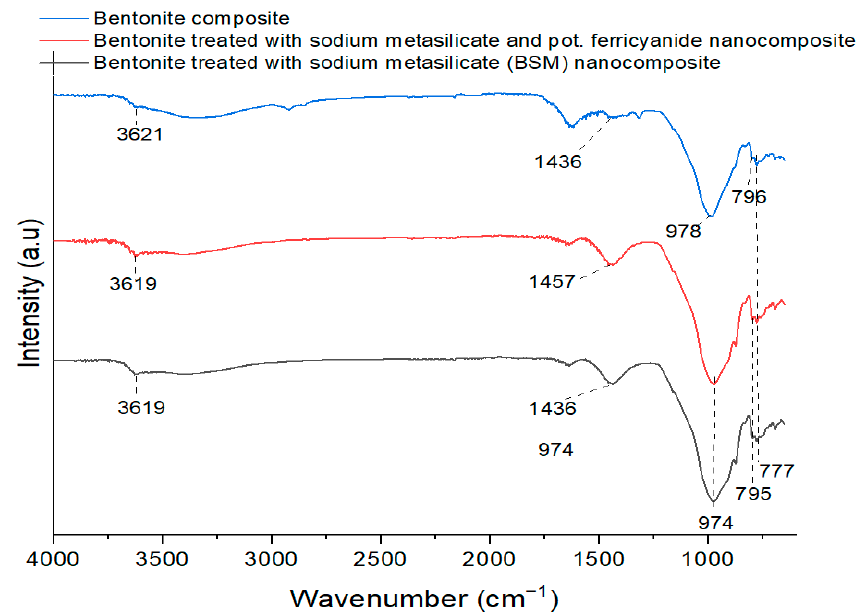
Figure 8. FTIR analysis of bentonite nanocomposite Bentonite treated with sodium metasilicate (BSM) nanocomposite bentonite treated with sodium metasilicate and potassim ferricyanide nanocomposite.